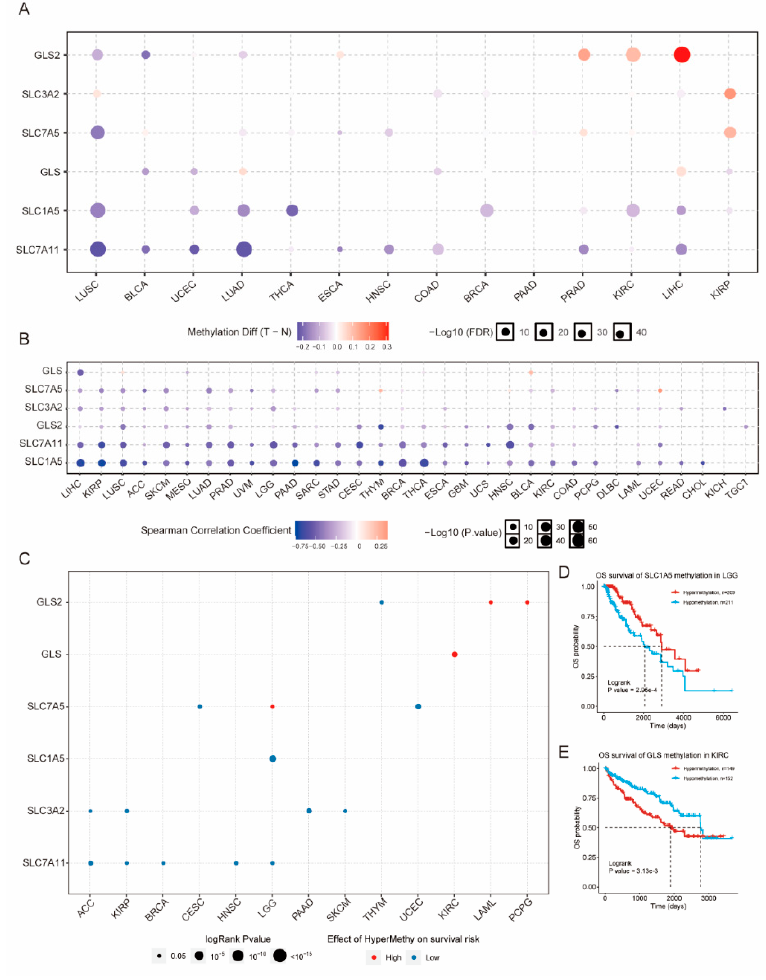
Figure 4. Alterations of glutamine metabolism (GLNM) regulators in terms of methylation in relation to gene expression and overall survival (OS): ( A ) Differential methylation of GLNM regulators between 14 paired normal and tumor tissues; ( B ) Correlation between mRNA expression and methy- lation. ( C ) Effects of hypermethylation of GLNM regulators on survival risk. Blue dots represent low risk and red dots represent high risk. The sizes of the dots represent significance. ( D , E ) KM plots showing the differences in overall survival between patients in low and high hypermethylation groups for SLC1A5 in LGG ( D ) and GLS in KIRC ( E